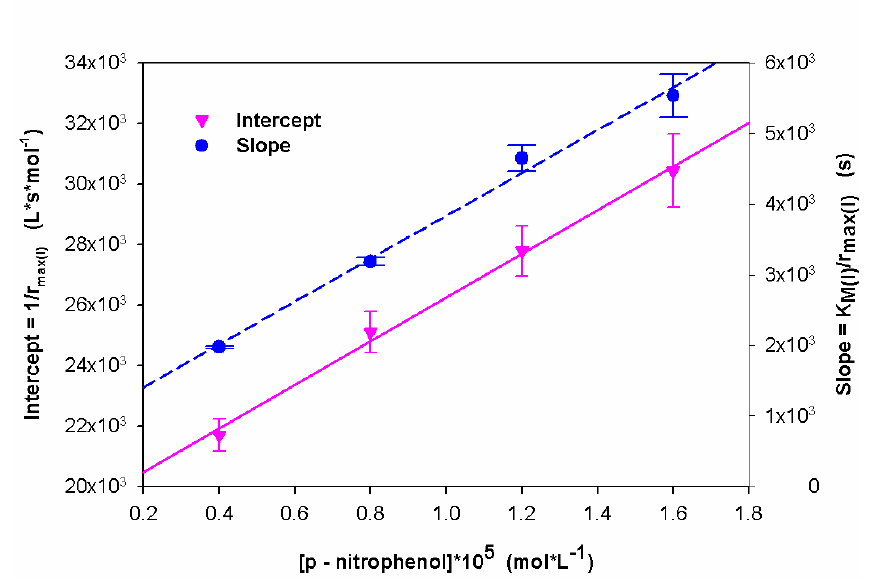
Fig. 3 Linear dependence of the slopes and intercepts of Lineweaver – Burk plots on the con- centration of the